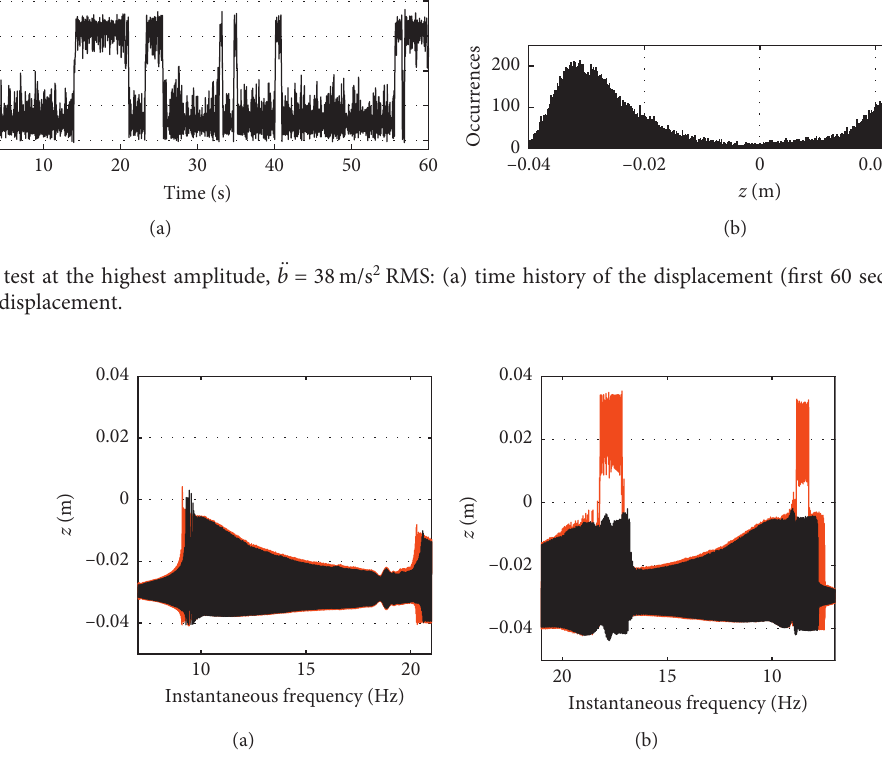
� 4 . 5mm; orange line: b 0